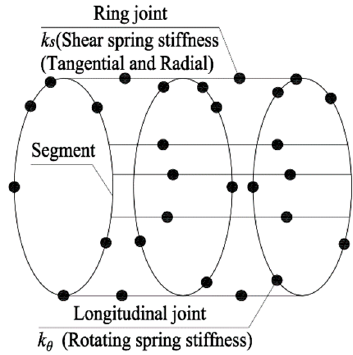
Figure 1. Analytical model of staggered seam assembly.